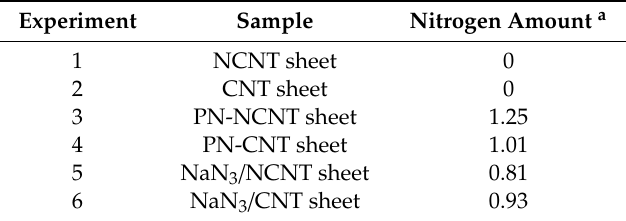
Table 1. Nitrogen amount of each sample (mmol/grams of sample).